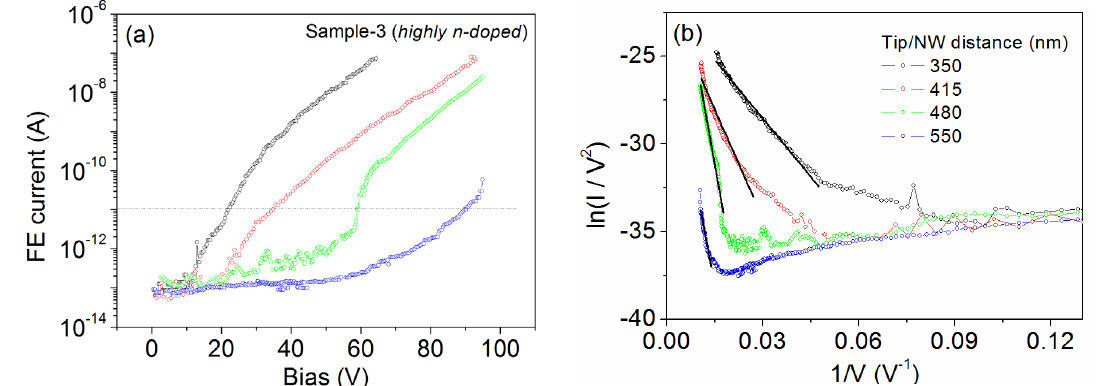
Figure 3. FE characterization of highly n -doped GaAs NWs. ( a ) I − V characteristics measured for Sample-3 for different values of the separation d . ( b ) FN plots and linear fittings (solid